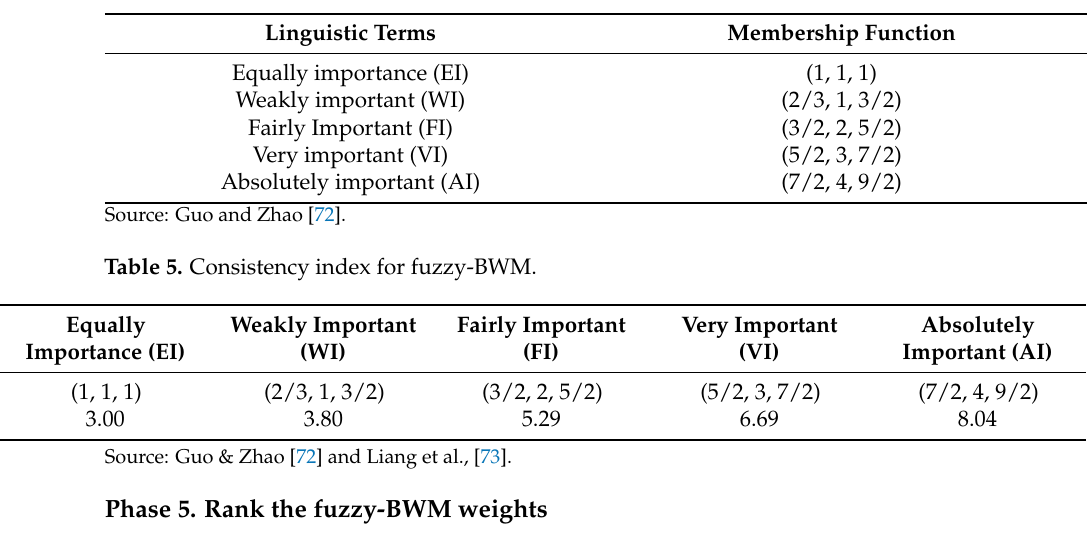
Table 4. Transformation rules of linguistic scale.